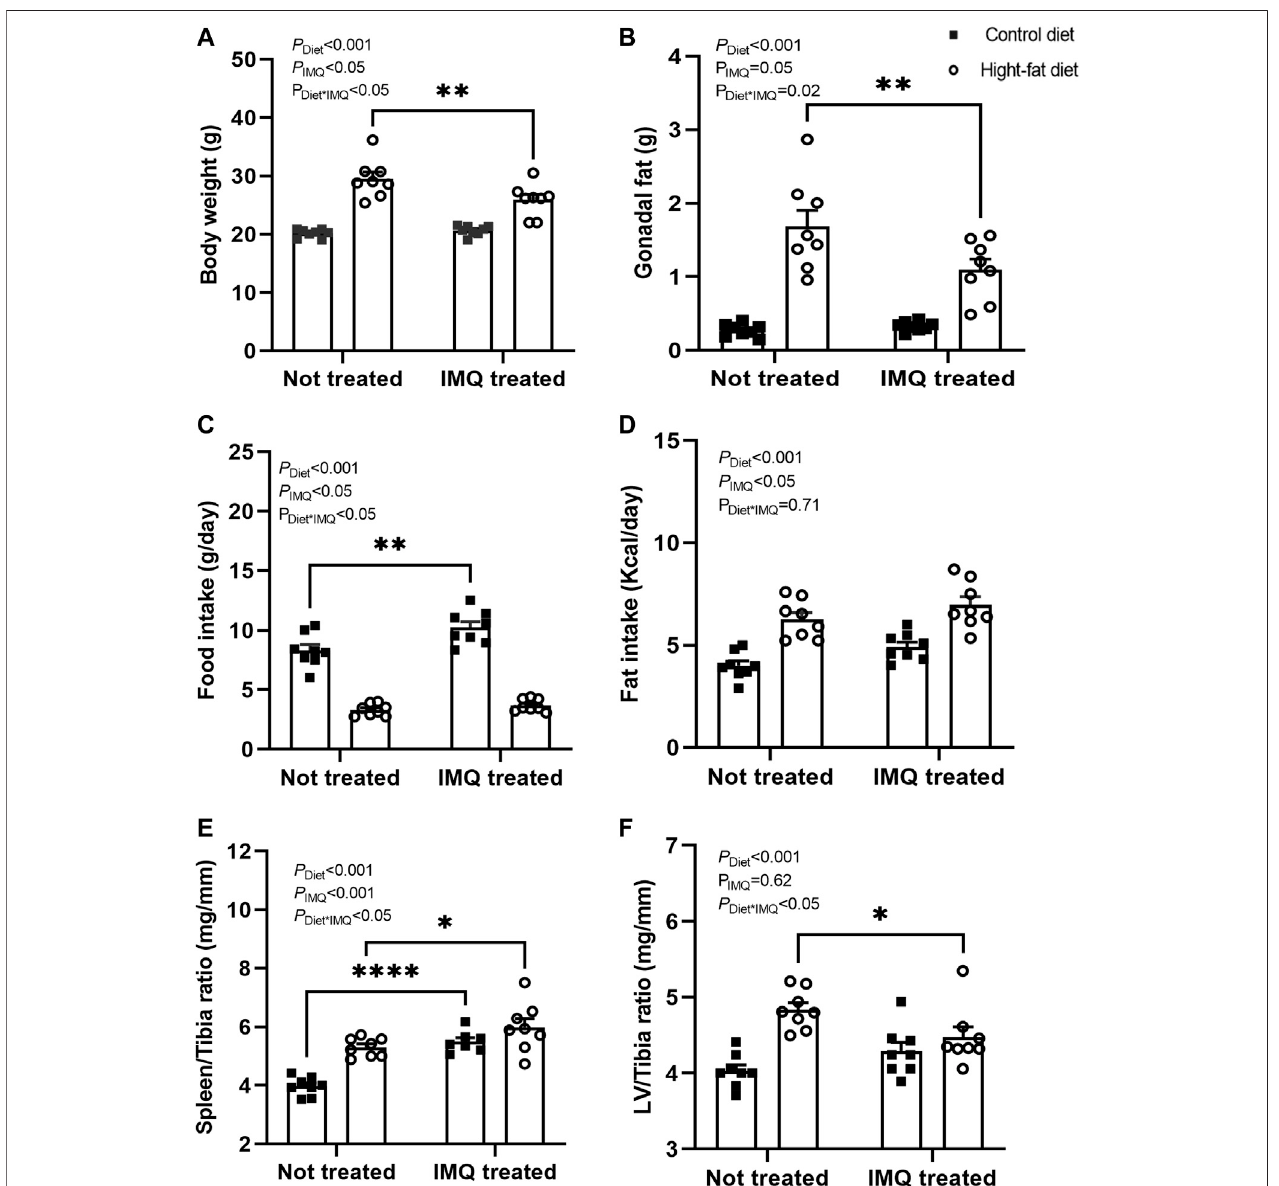
FIGURE 1 | High-fat diet and imiquimod treatment affected body morphology. (A) Body weight and (B) gonadal fat pad mass were higher in high-fat diet mice compared to control diet mice after 6 weeks of treatment, with this effect mildly but signi fi cantly attenuated by imiquimod (IMQ) (** p < 0.001 by Bonferroni post-hoc comparison). (C) Average food intake calculated from weekly 24 h metabolic cage measurements was higher in control than high-fat diet mice, with a further small but signi fi cant increase in IMQ-treated versus untreated control diet mice. (D) Calculated average Kcal of fat intake was higher in high fat than control diet mice and signi fi cantly higher in IMQ than in untreated mice. (E) Spleen-to-tibia ratio was greater in both IMQ-treated and high-fat diet mice. (F) Left ventricle (LV)-to-tibia ratio was increasedbyfatdietwiththeeffectmildlyattenuatedbyIMQ(* p < 0.05byBonferronipost-hoccomparison).n=8pergroupwithindividualdatapointsandmean±SEM alsoshown.Datawerecomparedbytwo-wayANOVA,with P D iet =maineffectofdiet; P IMQ =maineffectoftreatment; P Diet*IMQ =interactionbetweendietandtreatment. Bonferroni post-hoc comparisons: * p < 0.05, ** p < 0.001, **** p < 0.001).